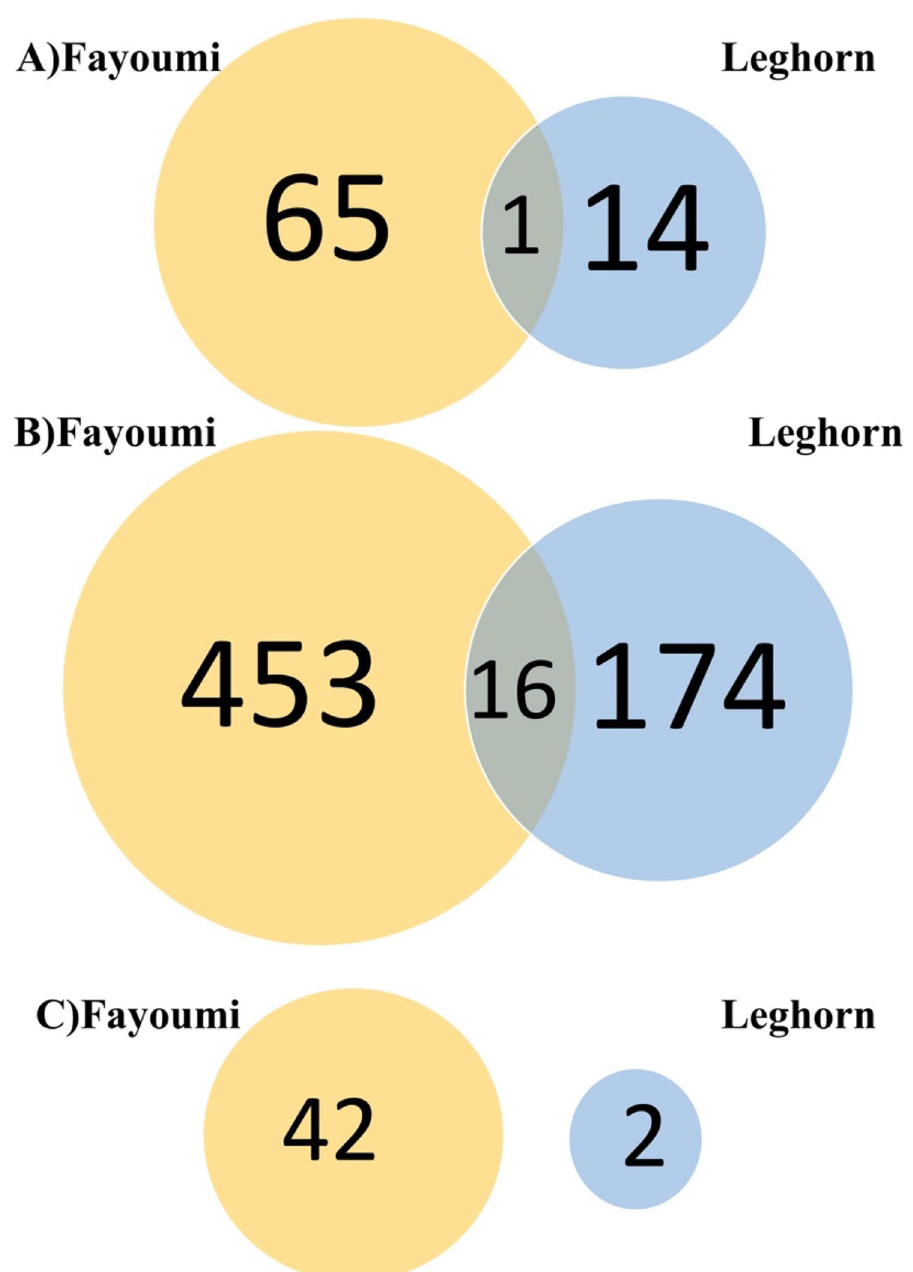
Figure 2. Venn diagrams displaying the number of overlapping differentially expressed genes (DEG) that overlapped between the two genetic lines by time point when comparing treated vs. non-treated birds. ( A ) Overlapped DEGs between Fayoumis and Leghorns at 2 dpi. ( B ) Overlapped DEGs between the two genetic lines at 6 dpi and ( C ) Overlapped DEGs between the two genetic lines at 10